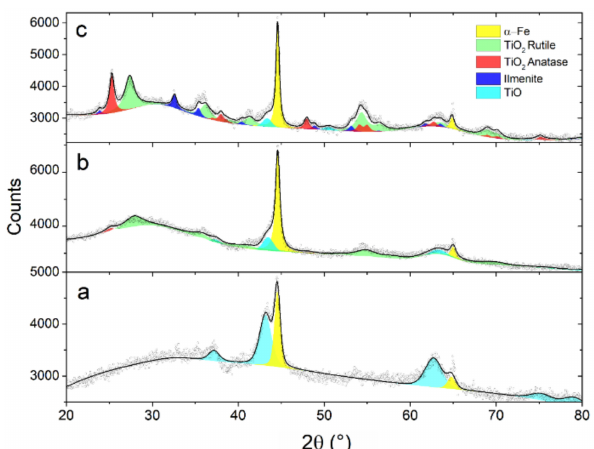
Figure 8. XRD patterns of Fe/TiO x NCs. ( a ) As-prepared sample; ( b , c ) After thermal treatment in a H 2 atmosphere, 1 MPa, for ( b ) 4 h and ( c ) 24 h. The colored areas highlight the contributions of different phases to the Rietveld refinement. Grey circles represent experimental data, while the black solid line shows the overall best fit.